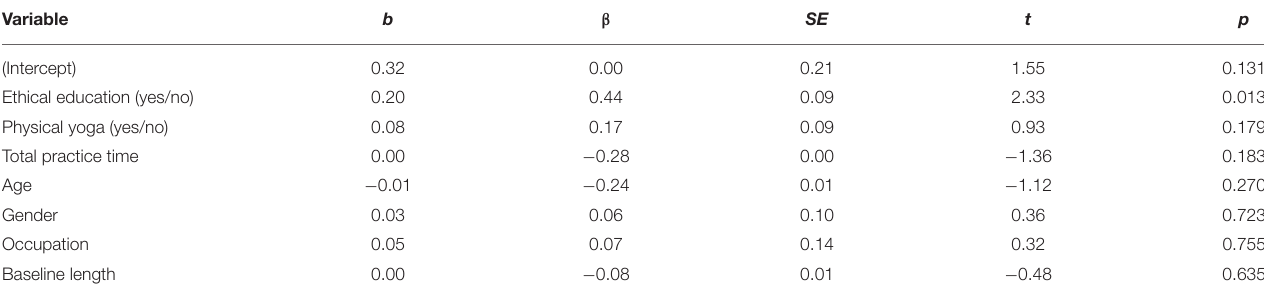
TABLE 4 | Regression model for Tau- U well-being estimates as dependent variable and effective component, age, gender, and baseline length as predictors ( df = 36).